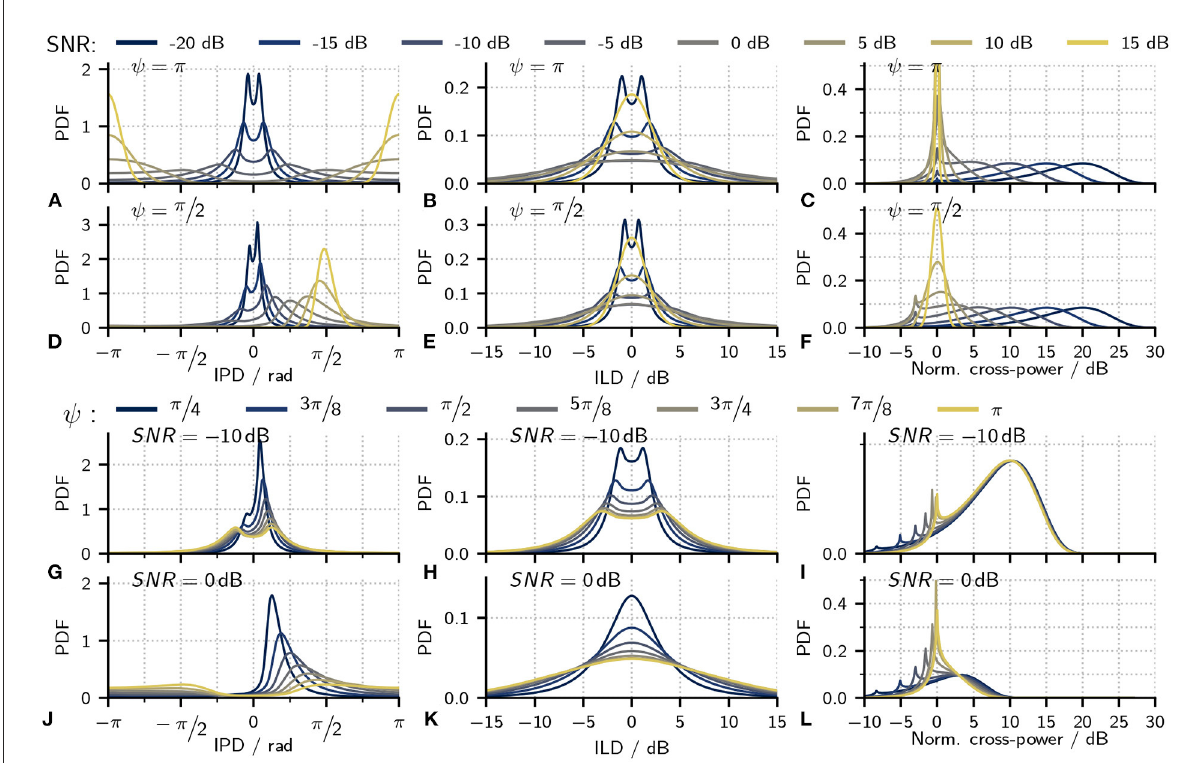
FIGURE3 Exemplary marginal PDFs for IPDs (first column), ILDs (second column), and the cross-power (third column). For better visualization, the cross-power values were normalized with the squared tone amplitude so that the x-axis shows 10log 10 π (top-row) and ψ fixed signal phases ψ π / 2 (bottom row). Different colors indicate results at different SNRs. (G–L) PDFs calculated for two = = fixed SNRS: 10dB (top-row) and 0dB (bottom row). Different colors indicate results at different signal phases ψ −